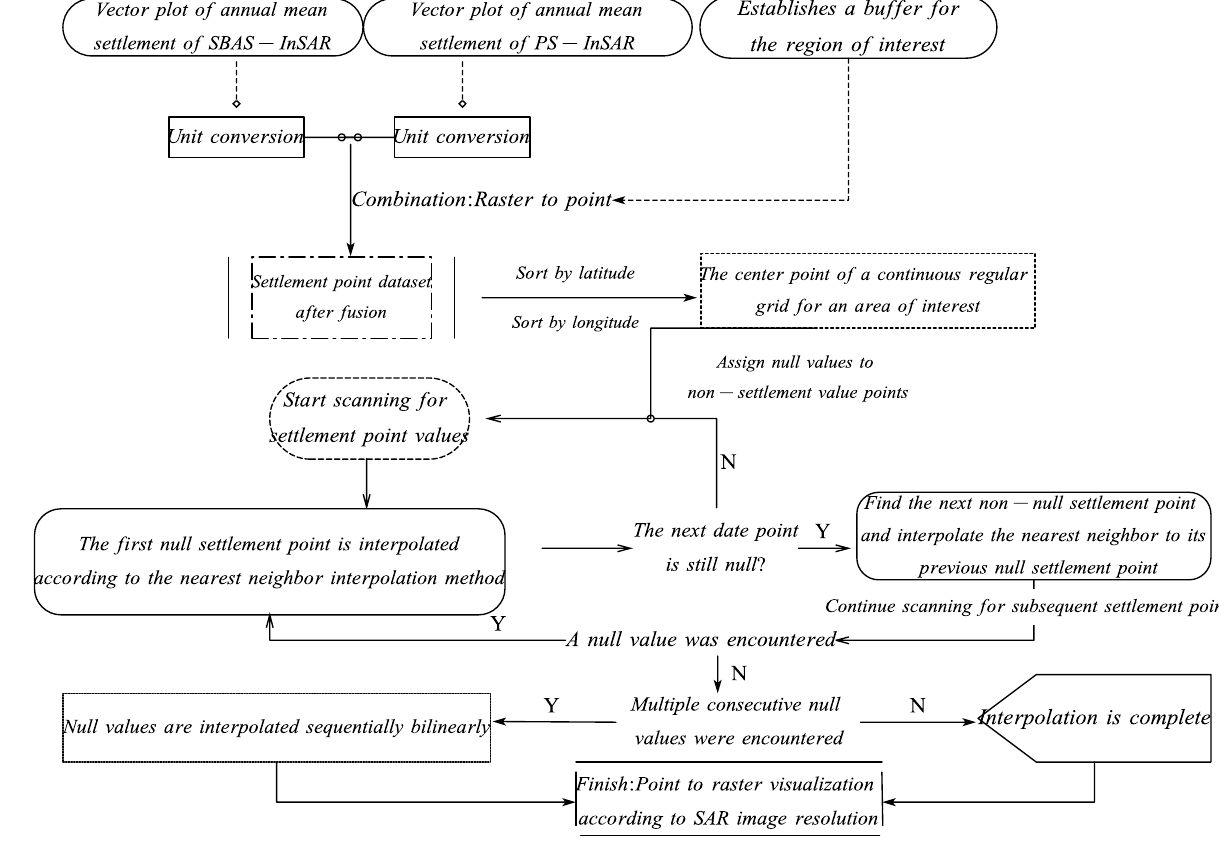
Figure 5. Interpolation flow scheme for missing data areas.